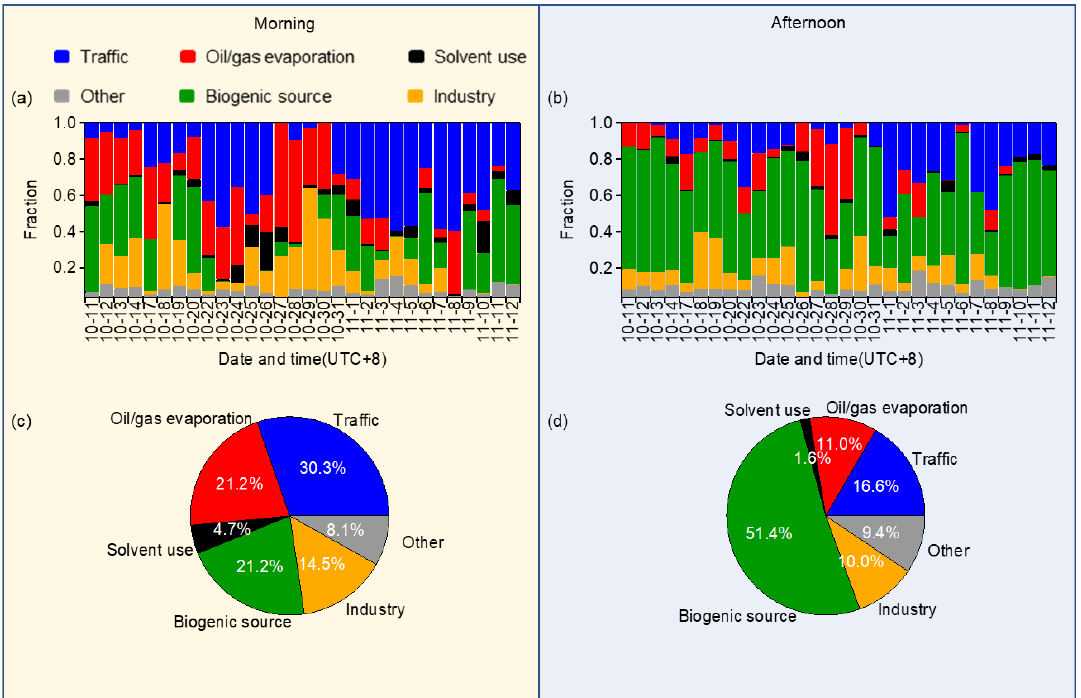
Figure 11. Relative contributions of different sources to the TVOC NCR in all morning samples ( a ) and the average ( c ), and in all afternoon samples ( b ) and the average ( d ).